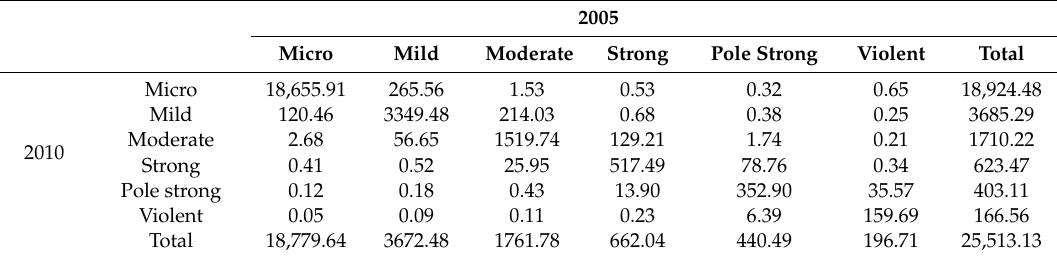
Table 6. The transfer matrix of soil erosion intensity grades in the Taohe River Basin from 2005 to 2010 (km 2 ).